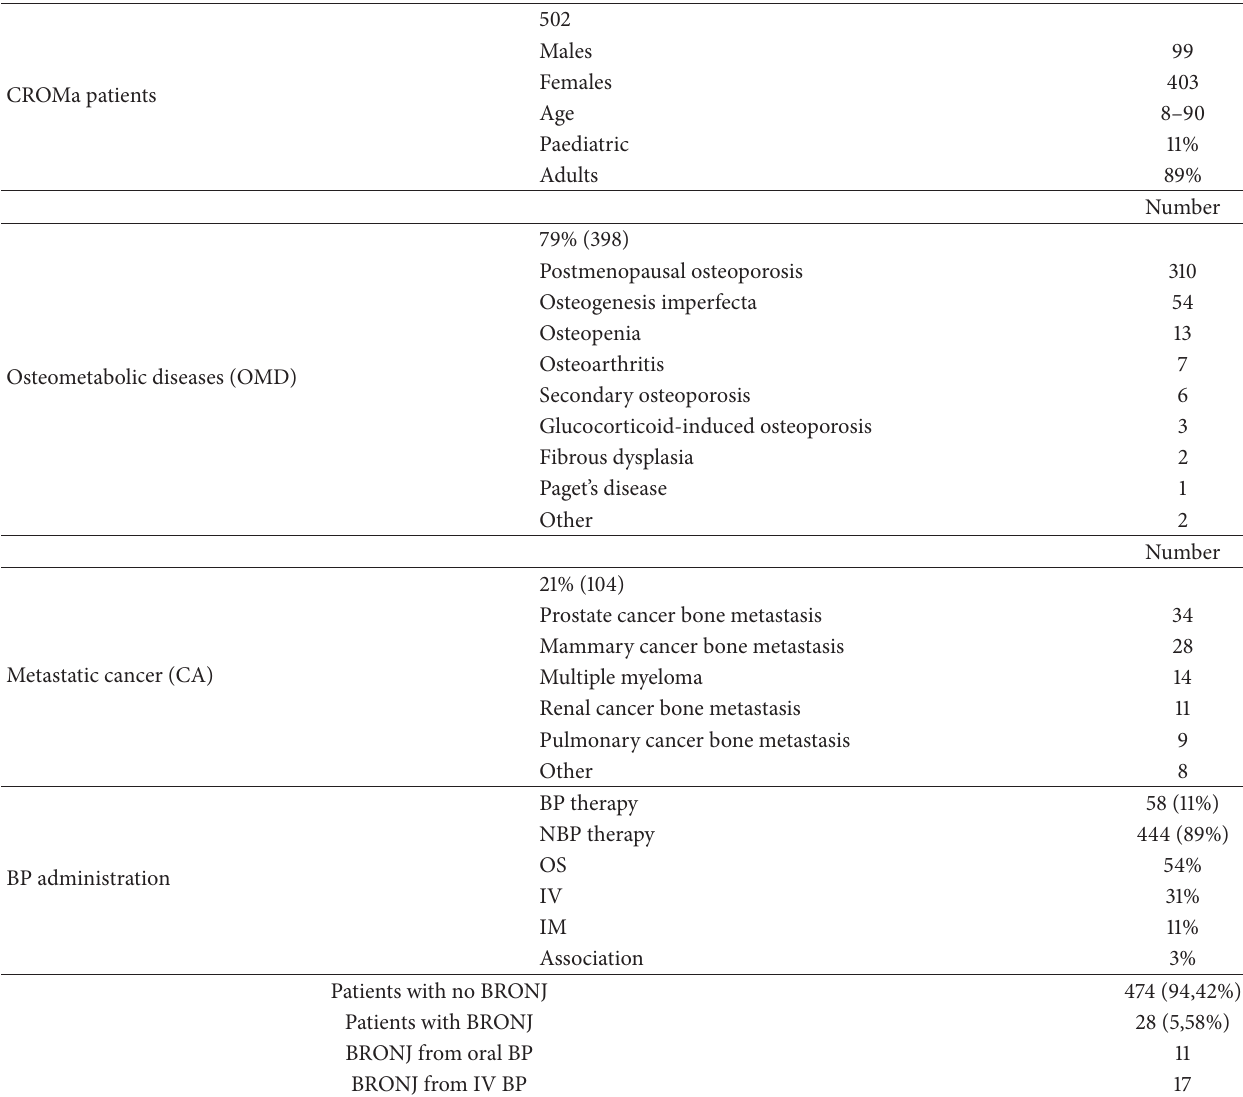
Table 3: Data from CROMa